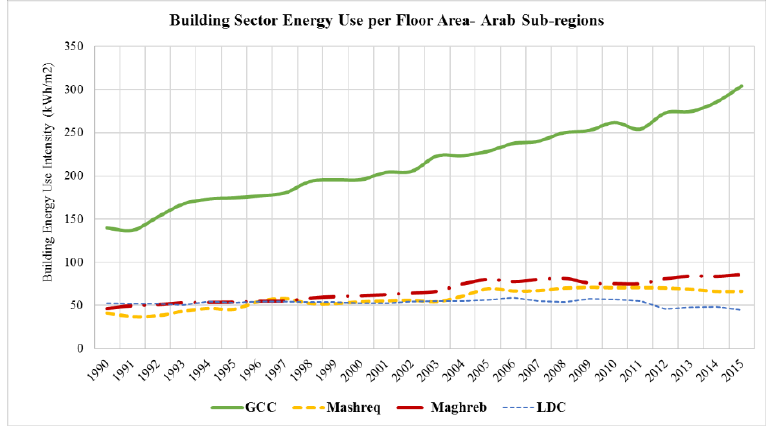
Figure 17. Building sector energy use per floor area for Arab sub-regions for the 1990–2015 period.